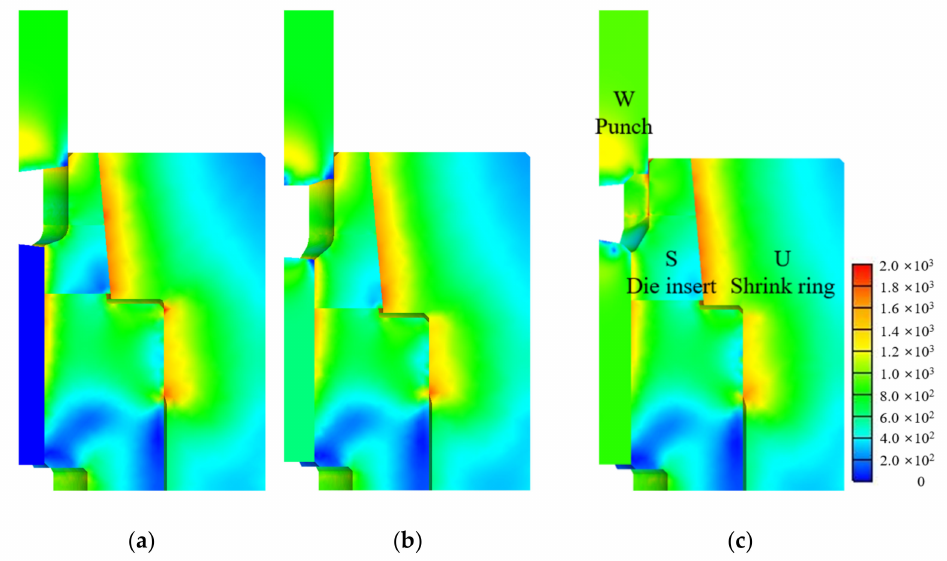
Figure 5. Predicted effective stresses on the die parts at the end of each stage: ( a ) stage 1; ( b ) stage 2; ( c ) stage